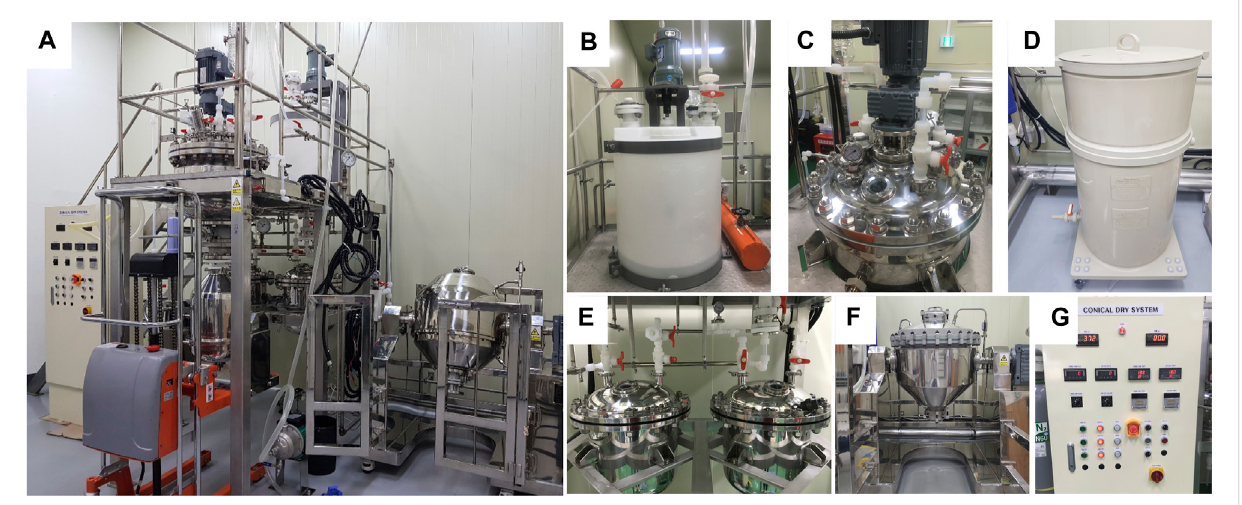
FIGURE 1 (A) Mass puri fi cation facility, (B) Feed tank for dissolving the NaI, (C) Mixing tank for boiling solution and recrystallization process, (D) Filter unit for separationofNaIcrystalandmotherliquor, (E) Receivertanksforcollectingvaporfrommixingtankanddryer, (F) ConicaldryerfortheNaIpowderdrying, (G) Main controller to control all the